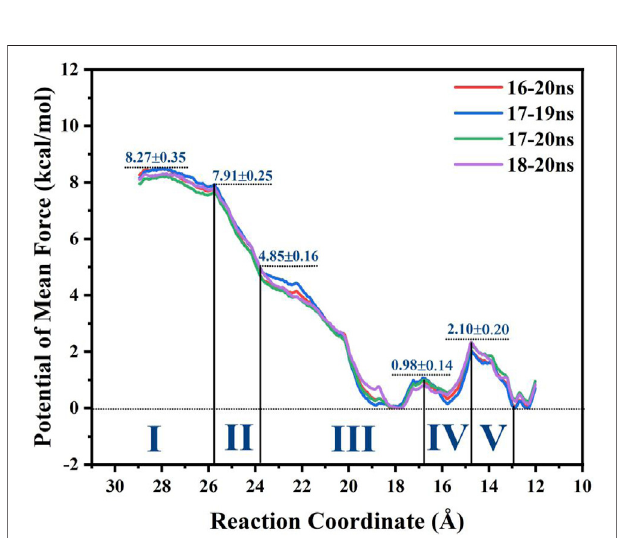
FIGURE 9 | Potential mean force (PMF) of GlcN6P recognition and delivery along the P1 channel evaluated by MM MD simulations incorporating an umbrella sampling technique.